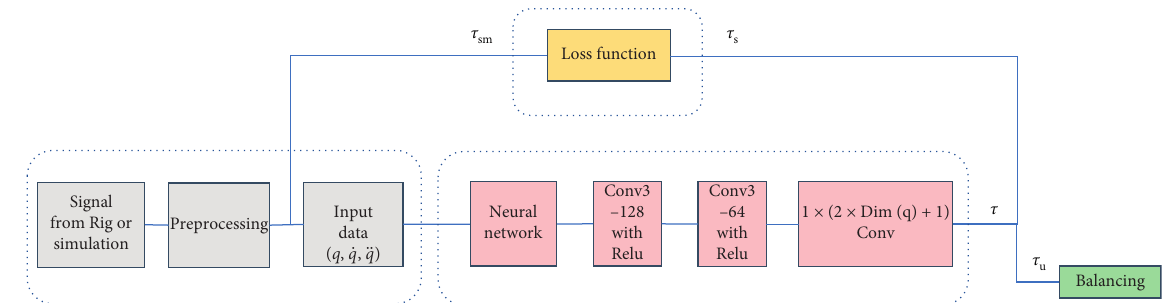
Figure 1: Overview of the unsupervised network, where Conv3–128 means a convolutional layer with 128 filters of size 1 × 3 and Relu means rectified linear unit activation